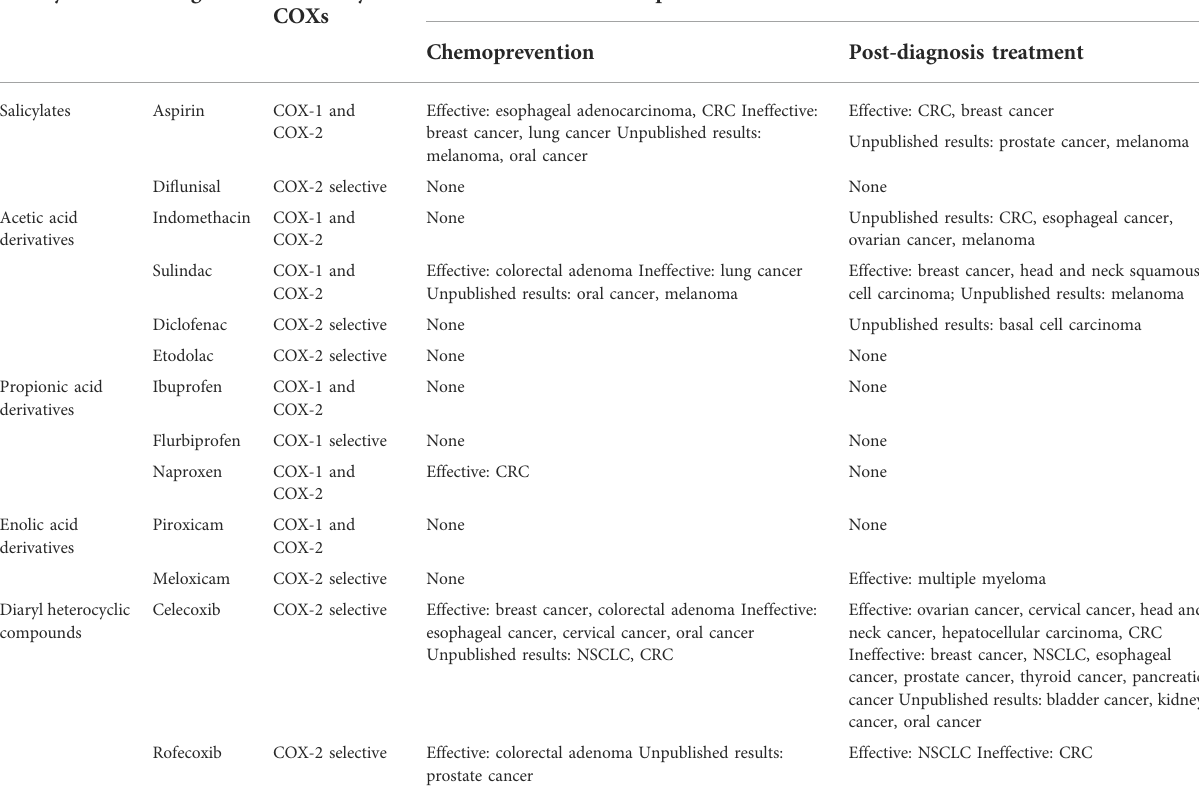
TABLE 1 Classi fi cation, selectivity and anti-cancer clinical trials of classical NSAIDs.